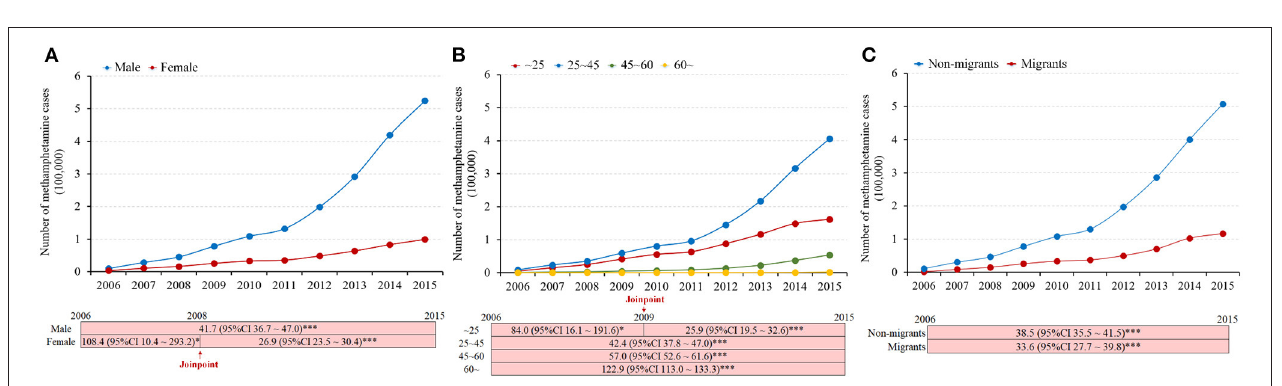
FIGURE 2 | Trends in the annual number of methamphetamine use cases, stratified by sex (A) , age groups (B) , and migrant status (C) , 2006–2015 in the mainland of China (*indicated p < 0.05; ***indicated p <